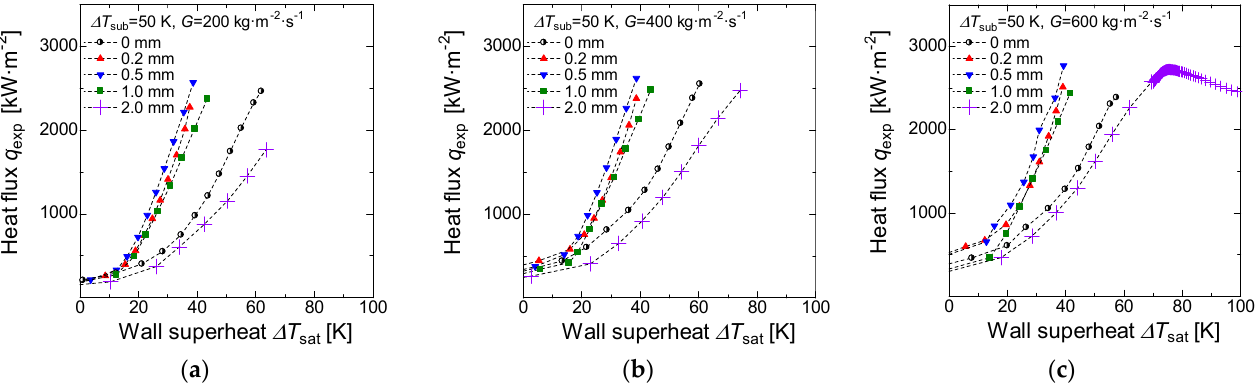
Figure 5. Maximum heat flux for all the porous thickness, inlet subcooling temperature ∆ T sub = 50 K: ( a ) G = 200 kg · m − 2 · s − 1 , ( b ) G = 400 kg · m − 2 · s − 1 , ( c ) G = 600 kg · m − 2 · s − 1 .